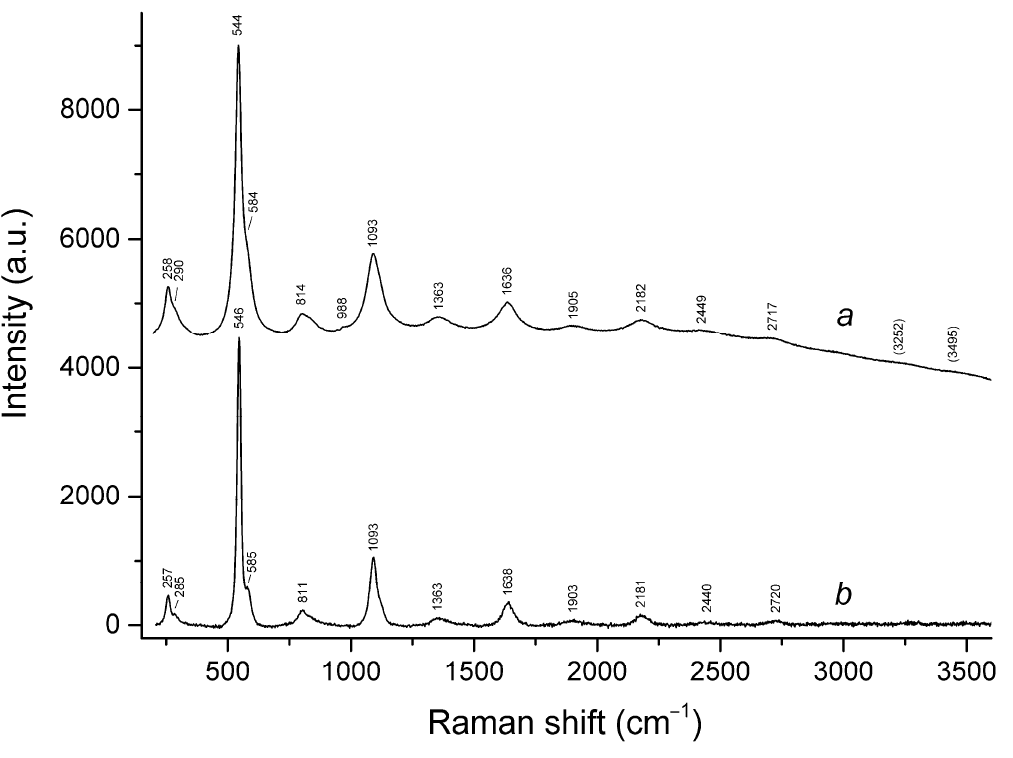
Figure 10. Raman spectra of ( a ) KL, and ( b ) ZK.